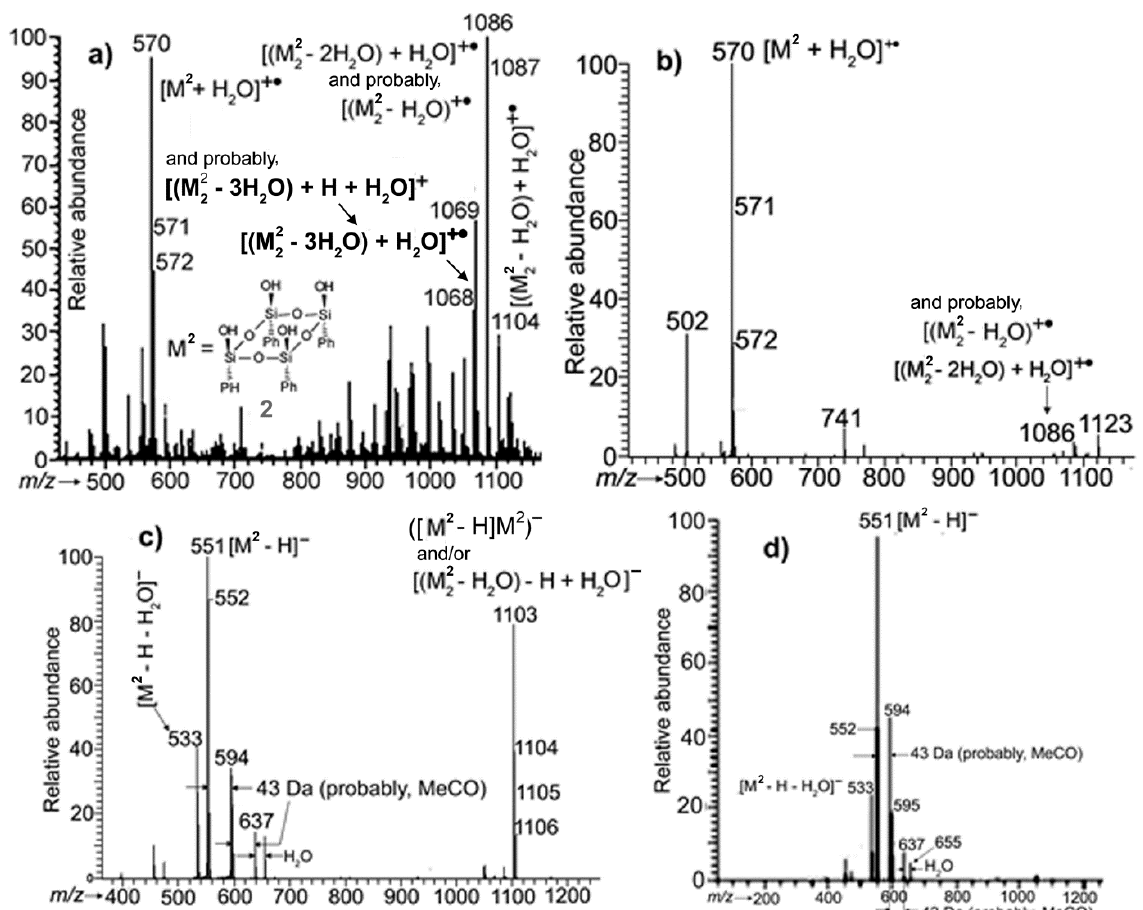
Figure 4. APCI mass spectra of isomer 2 : ( a , b )—recorded in the PI mode when the concentration of 2 in analyte was greater and less, respectively; ( c , d )—in the NI mode, analogously.